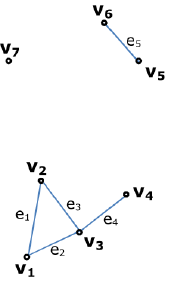
Figure 1. A dynamic sensor fiel in which the communicationranges of sensor nodes are indicated by the radii of balls.